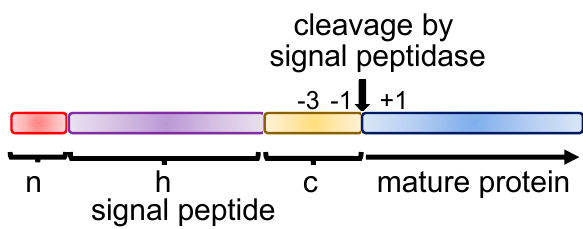
Figure 1. Schematic presentation of a typical signal peptide. Secretory proteins contain an additional sequence at their N-termini named signal peptide or signal sequence. N-terminal portion of the secretory proteins containing a signal peptide and part of a mature protein shown on the scheme. Usually signal peptides include a short positively charged n-region (1–5 amino acid residues) followed by hydrophobic domain (h-region, 7–15 hydrophobic amino acid residues) and c-region with a cleavage site for signal peptidase (3–7 amino acid residues). Positions of the − 3, − 1, and + 1 amino acid residues are shown. See text for details and for the references.